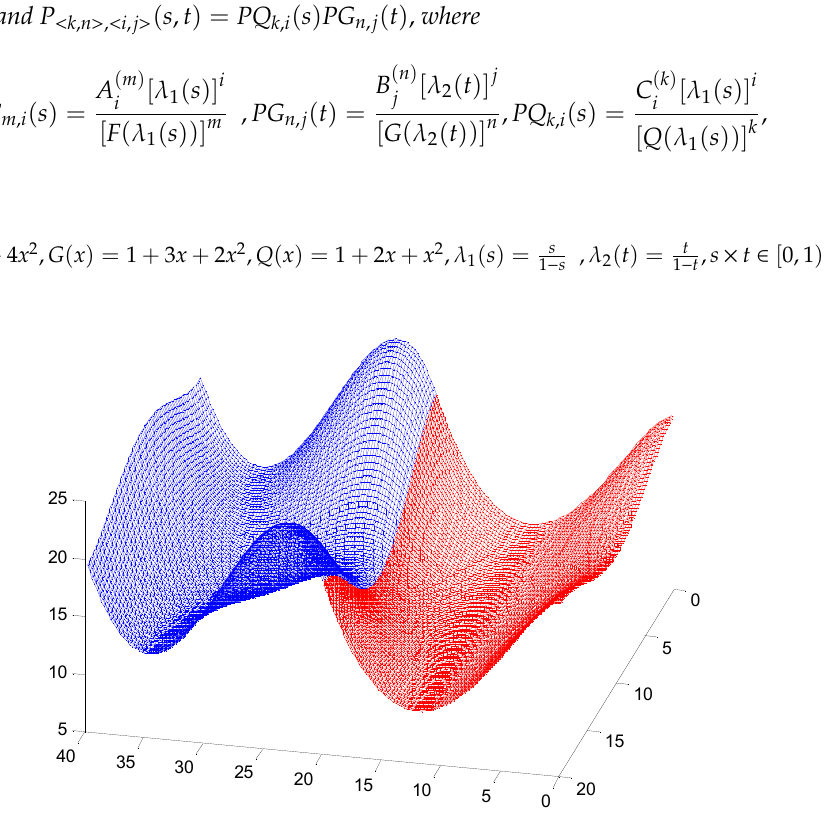
Figure 5. G 1 smooth continuity of two S- λ surfaces in the v direction.